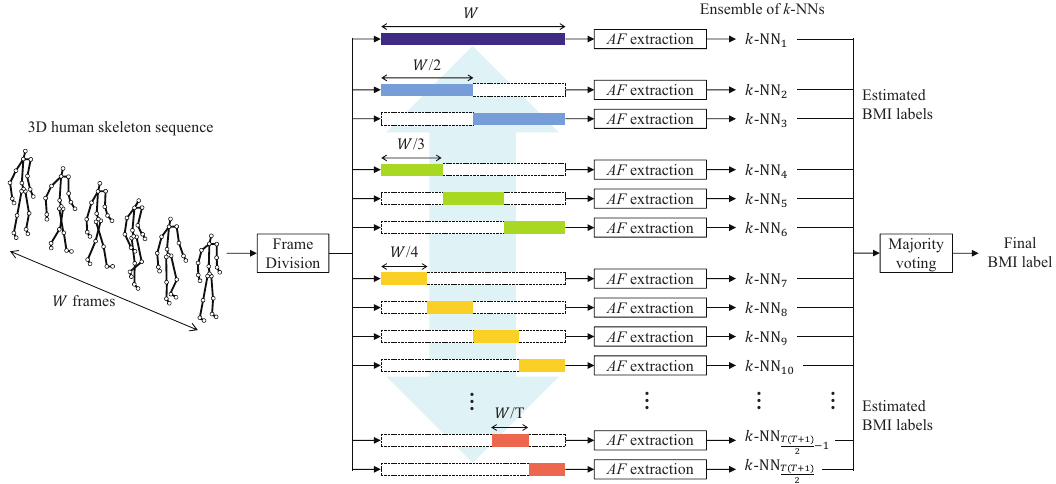
Figure 4. Schematic overview of the proposed method for skeleton-based BMI